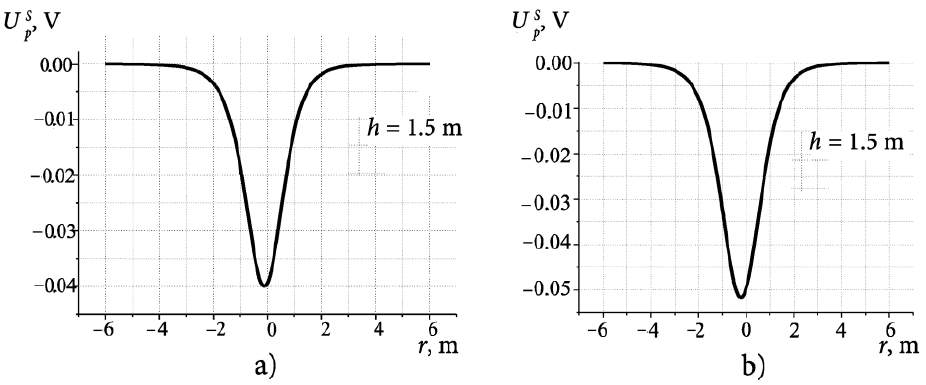
Figure 4. The flow characteristic: ( a )—corresponds to the free space for H = ∞ , h =1.5 m; ( b )—the flow characteristic for H = 6 m, h = 1.5 m.